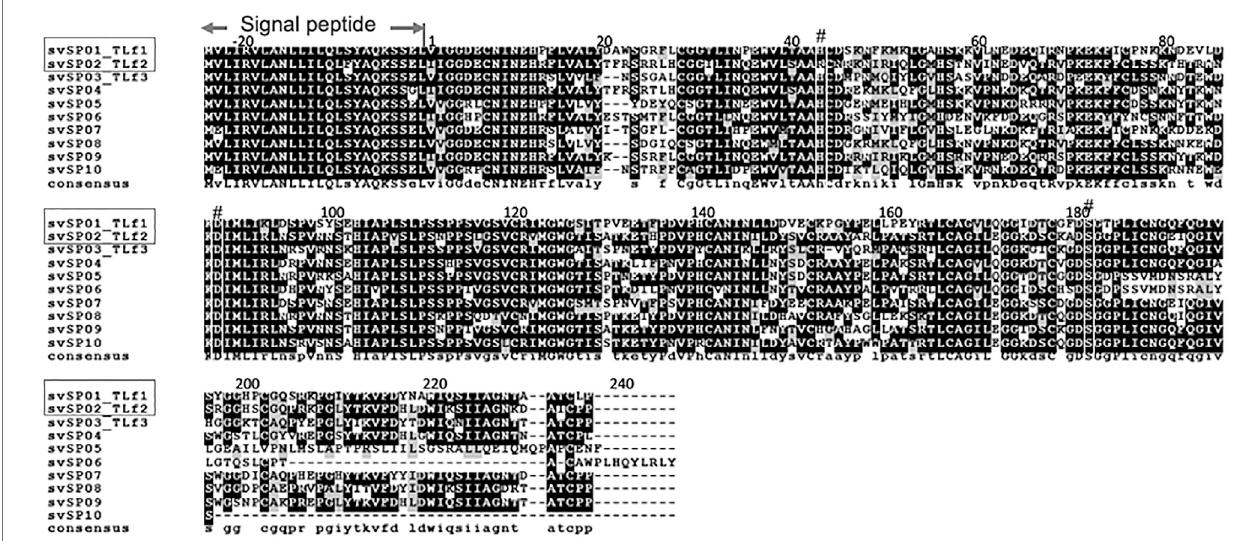
FIGURE 3 | Amino acid sequence alignment of Protobothrops fl avoviridis serine proteases identi fi ed from genome sequence. Multiple sequence alignment was conductedbyCLUSTALW(ver.2.1)onDDBJwebsiteathttp://clustalw.ddbj.nig.ac.jp/usingaminoacidsequencesof P. fl avoviridis serineproteases,svSP01 ∼ svSP10, identi fi ed from genome data (Shibata et al., 2018) and represented byusing BOXSHADE 3.21. svSP01_TLf1 isFlavoxobin, and svSP02_TLf2isinactive serine protease isoform, of which active site His43 was replaced by Arg. The symbol # indicates the catalytic triad, Asp88, His43, and Ser182.